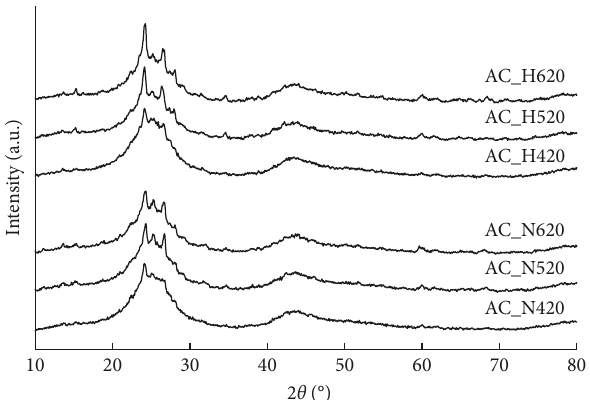
Figure 2: XRD patterns of the catalysts.